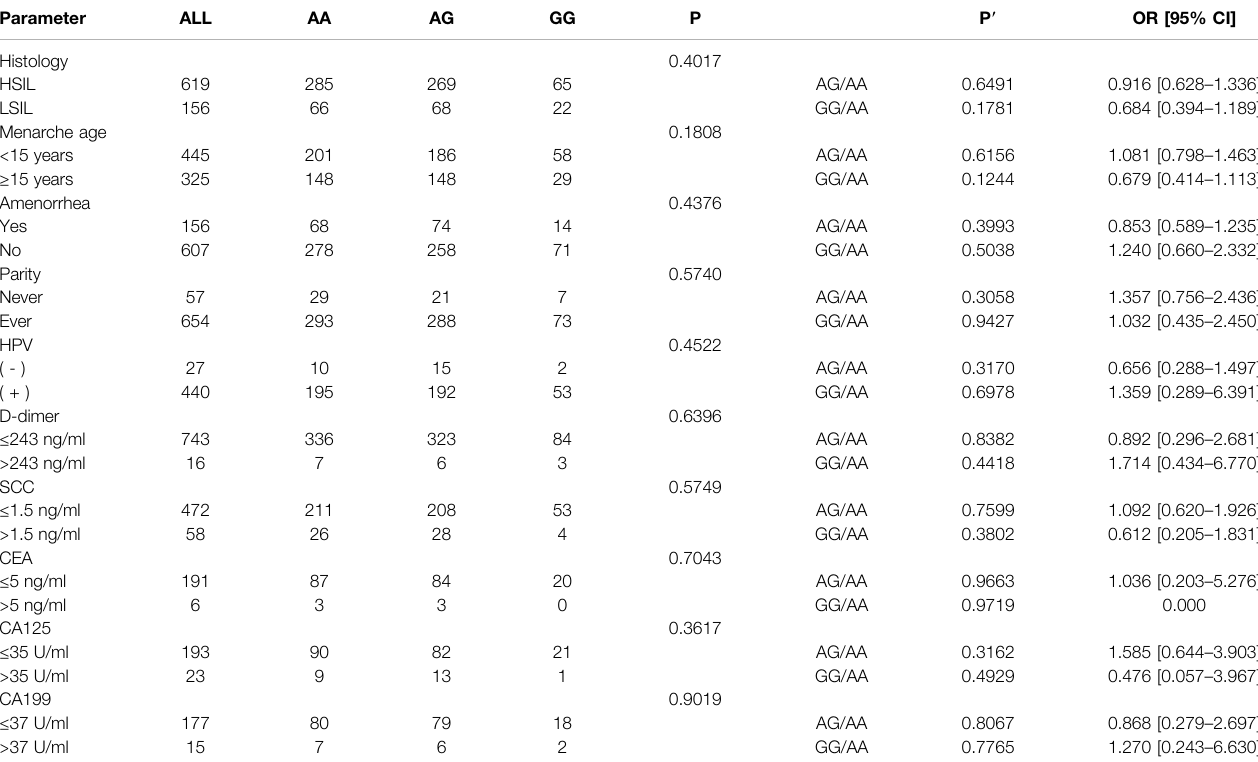
TABLE 9 | Comparison of genotype distribution frequencies with clinical parameters in the SIL group. Parameter